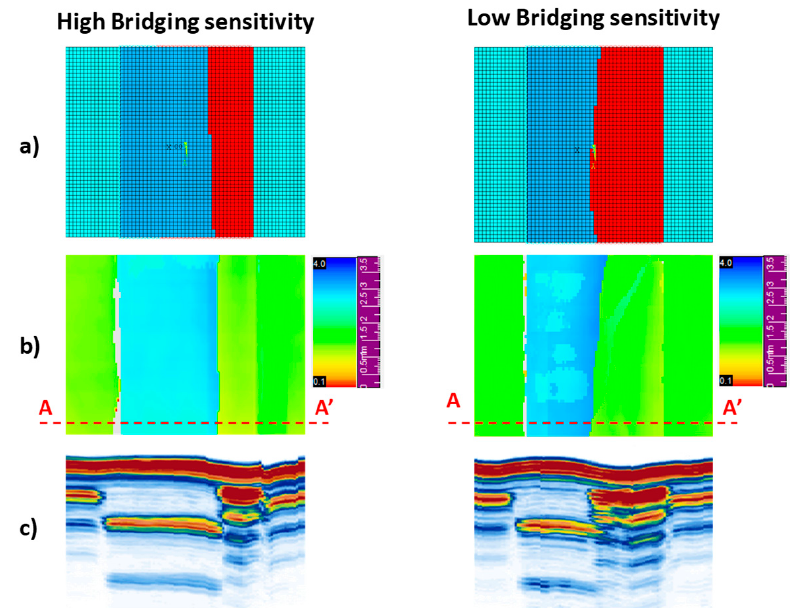
Figure 15. Non-destructive inspections: ( a ) numerical models, ( b ) C-scans, ( c ) S-scans.